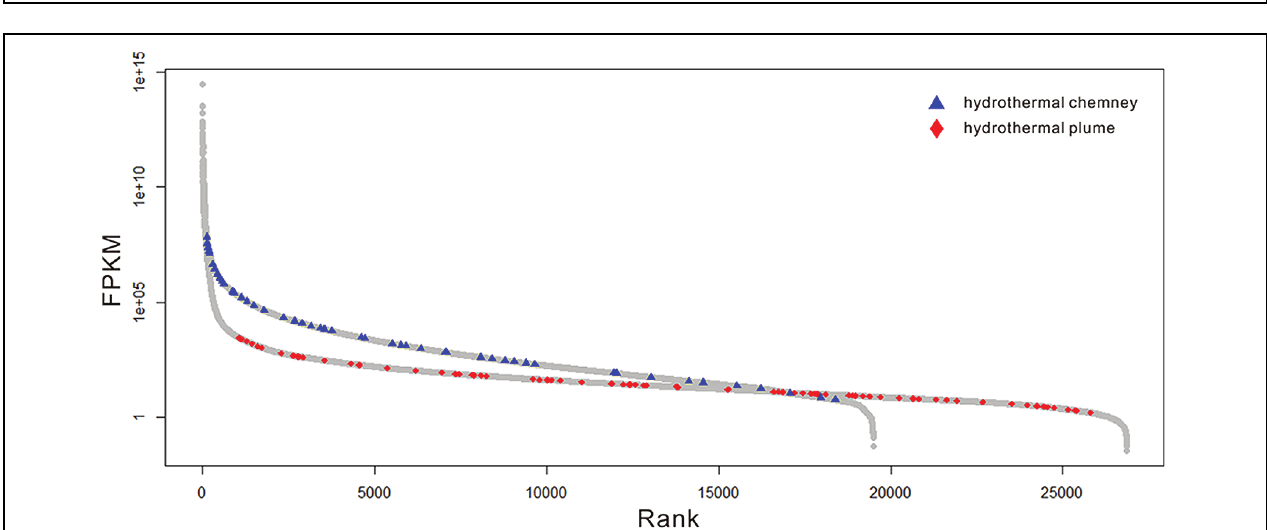
FIGURE 3 | Proposed metabolic and active pathways in this chimney community. The expression and presence of the genes are indicated by the color and thickness of the arrows, as shown in the bottom-right side bar. For genes with multiple hits, only the genes with the highest expression value (FPKM, expected fragments per kilobase of transcript per million fragments mapped) are displayed and discussed. The processes conducted by Archaea are shown on the left, whereas those conducted by bacteria are presented on the right. Detailed information of these genes is displayed in Tables 2–4 .